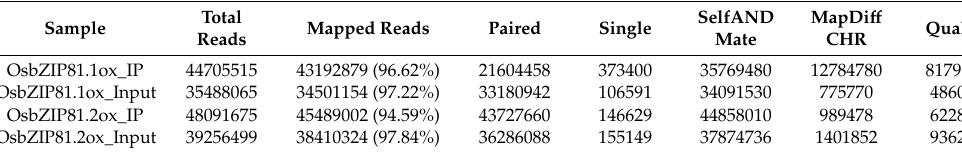
Table 1. Summary of ChIP-Seq data collected from OsbZIP81.1ox and OsbZIP81.2ox.